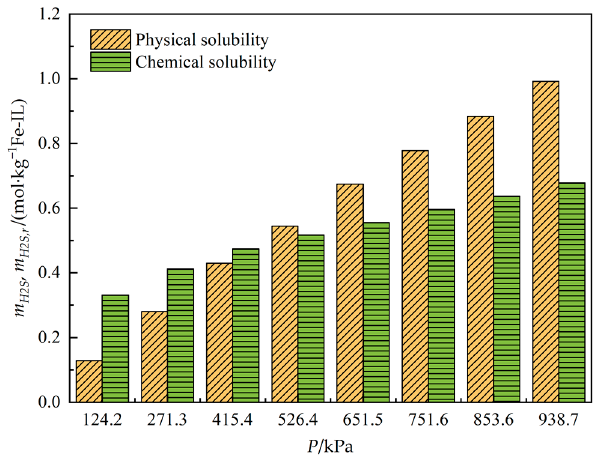
Figure 7. Physical and chemical solubilities of H 2 S in FeCl 3 /[bmim]Cl at a mole ratio of 0.6 and at 333.15 K.